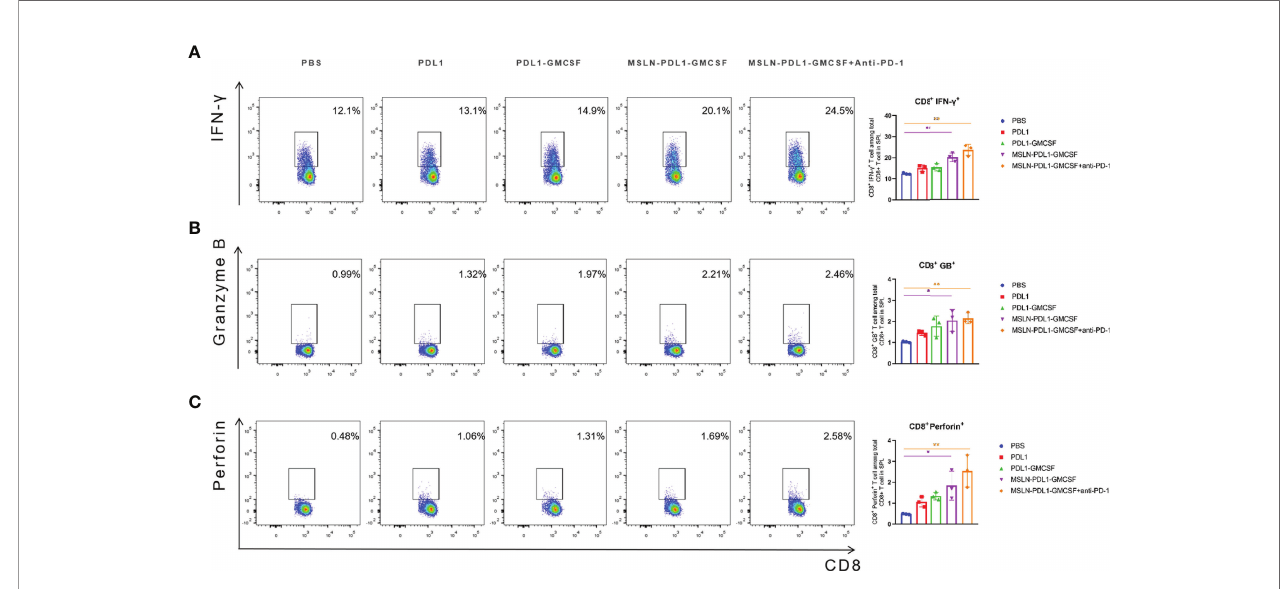
FIGURE 5 | DC vaccination produced a signi fi cantly enhanced cytotoxic T cell response. Spleen cells were isolated from each group 3 days after the second inoculation of C57BL/6 mice, and incubated with RPMI-1640 containing 10%FBS for 6 hours, adding PMA (50ng/mL), Brefeldin A(10ug/ml) and Ionomycin(1ug/ml). The cells were surface stained and intracellularly stained with FACS to analyze the expression of IFN- g (A) , granzyme B (B) and perforin (C) in CD8 + T cells. Mean ± SD (n=3). *p < 0.05, **p <